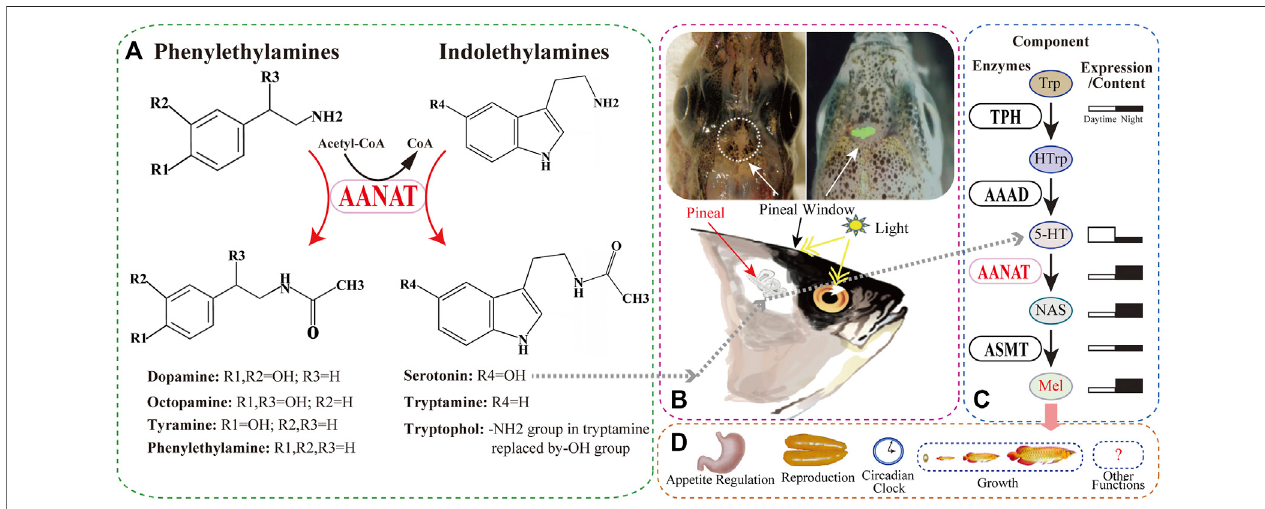
FIGURE 1 | The substrates of AANAT and one of its products (melatonin; Mel) synthesized in fi sh. (A) AANAT can catalyze arylalkylamines, including phenylethylamines (dopamine, octopamine, tyramine, and phenylethylamine) and indolethylamines (serotonin and tryptamine). (B) The fi sh pineal organ. Upper left: the depigmented area around the pineal window (circle) of a polar cod ( Boreogadus saida ) head (adopted from Falcón et al., 2011). Upper right: zebra fi sh pineal gland with enhancedgreen fl uorescent protein (EGFP) expressed under thecontrol of aanat2 promoter(Ben-Moshe et al., 2014).Down:melatoninsynthesis in the fi sh pineal gland through regulation of light. (C) Melatonin biosynthesis pathway and related enzymes including AANAT. (D) Multiple important functions of melatonin in various fi shes.